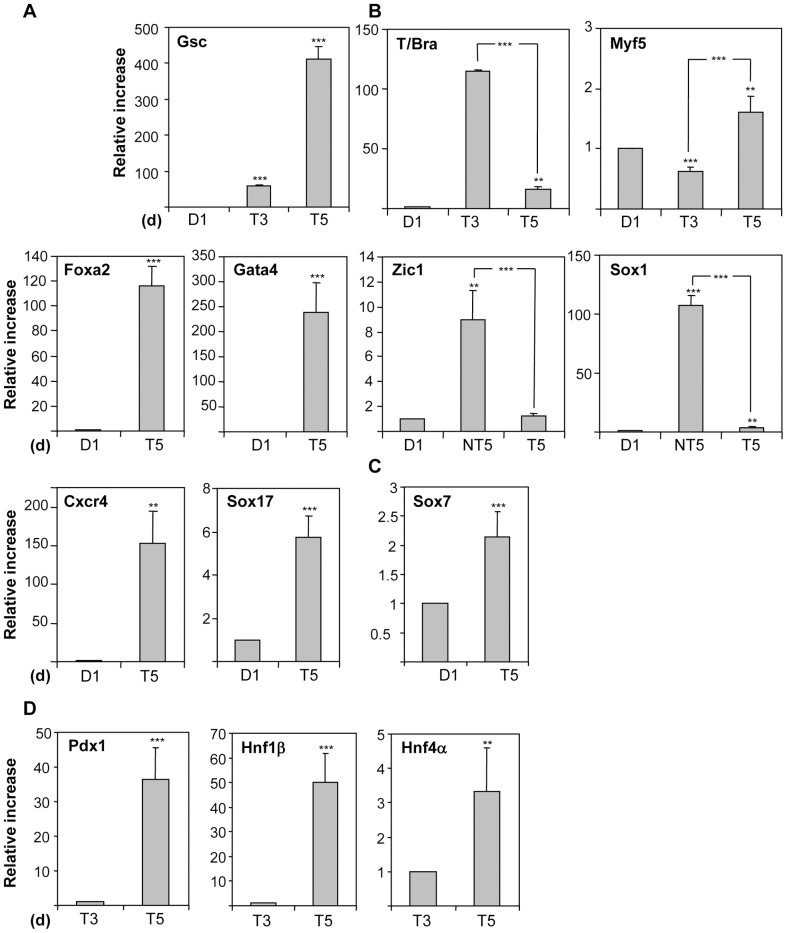
Gene expression of early germ-layer specific markers at stage 1 by qRT-PCR.Cells were induced to differentiate as EB in the presence of 100 ng/ml activin A as indicated in Fig. 1. After 3 or 5 days (stage 1), cultures were harvested and subjected to qRT-PCR analysis for the indicated early germ-layer (A–C) and foregut/pancreatic (D) markers. Histograms show the relative expression levels normalized to the loading control Hprt. Error bars indicate the standard deviations of 4 experiments. (d), days; T, treated cells; NT, non-treated cells. In A–C, p is calculated as compared to D1 and in D, as compared to T3. In D, the expression was analyzed from day 3 onwards as some of the markers were undetectable at day 1.